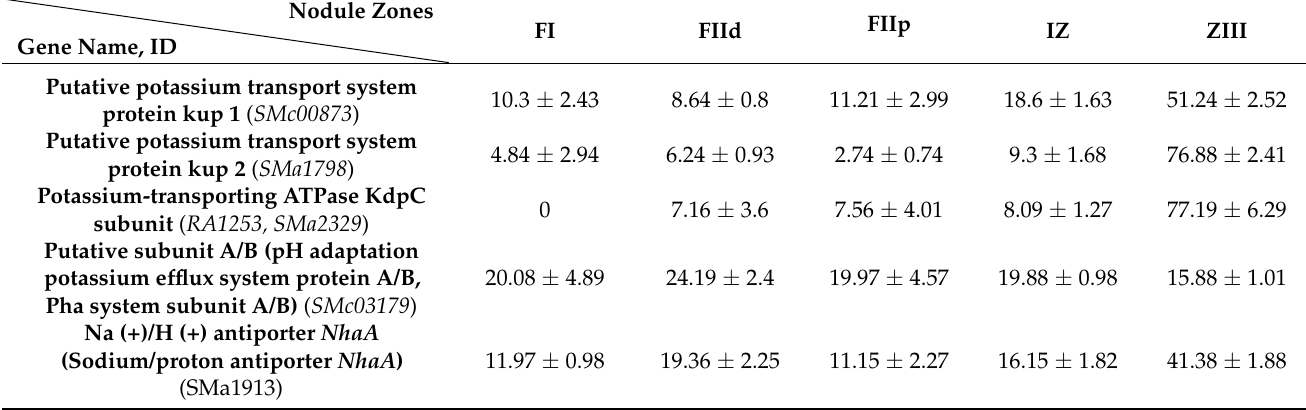
Table 2. Expression of potassium transporters/exchangers genes of Sinorhizobium meliloti in root nodule developmental zones. Data (relative read distribution among zones or organs (%)) were obtained from the Symbimics database. FI: Meristem; FIId: Distal infection zone; FIIp: Proximal infection zone; IZ: Interzone II–III; ZIII: nitrogen-fixing